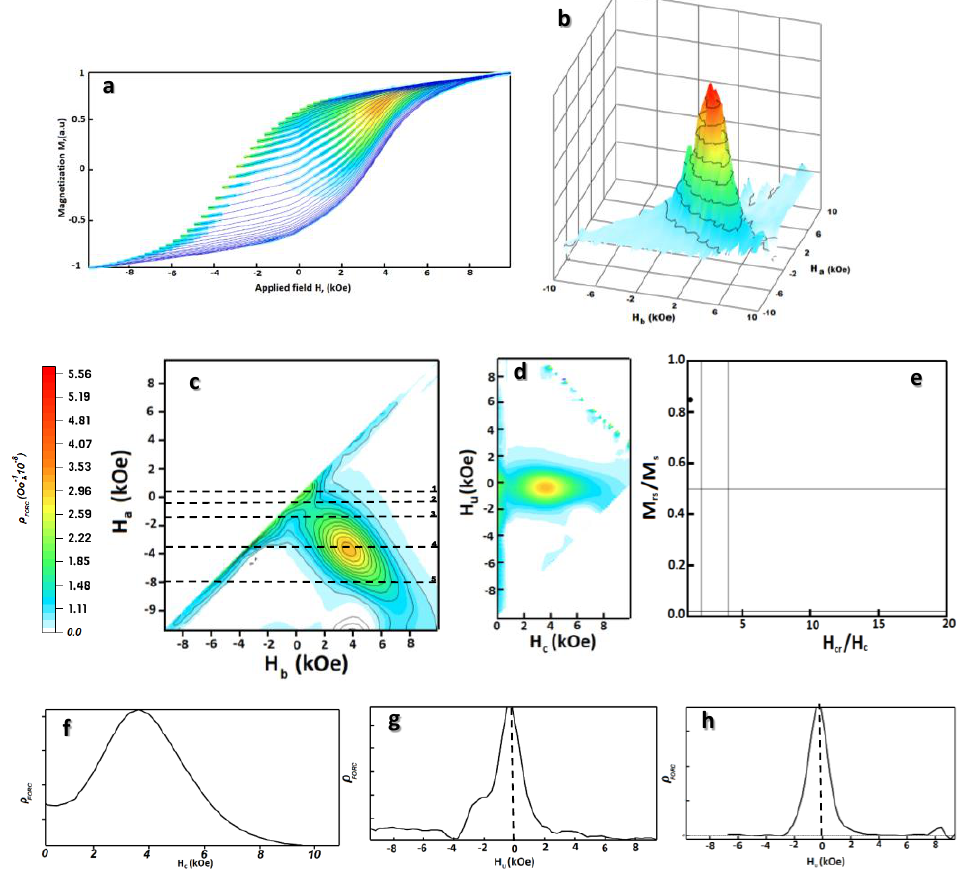
Figure 8. The calculated FORC analysis for sample F5 (milled and annealed at 400 °C); ( a ) a set of FORC measurements; ( b – d ) 3D and 2D diagrams calculated according to part a; ( e ) Day plot diagram; ( f ) cross section of the fork diagram with the maximum coercivity distribution (along the axis H c = 0); ( g , h ) cross section of maximum interaction distribution along the axis H u = 0 and H u = 3.5 kOe.